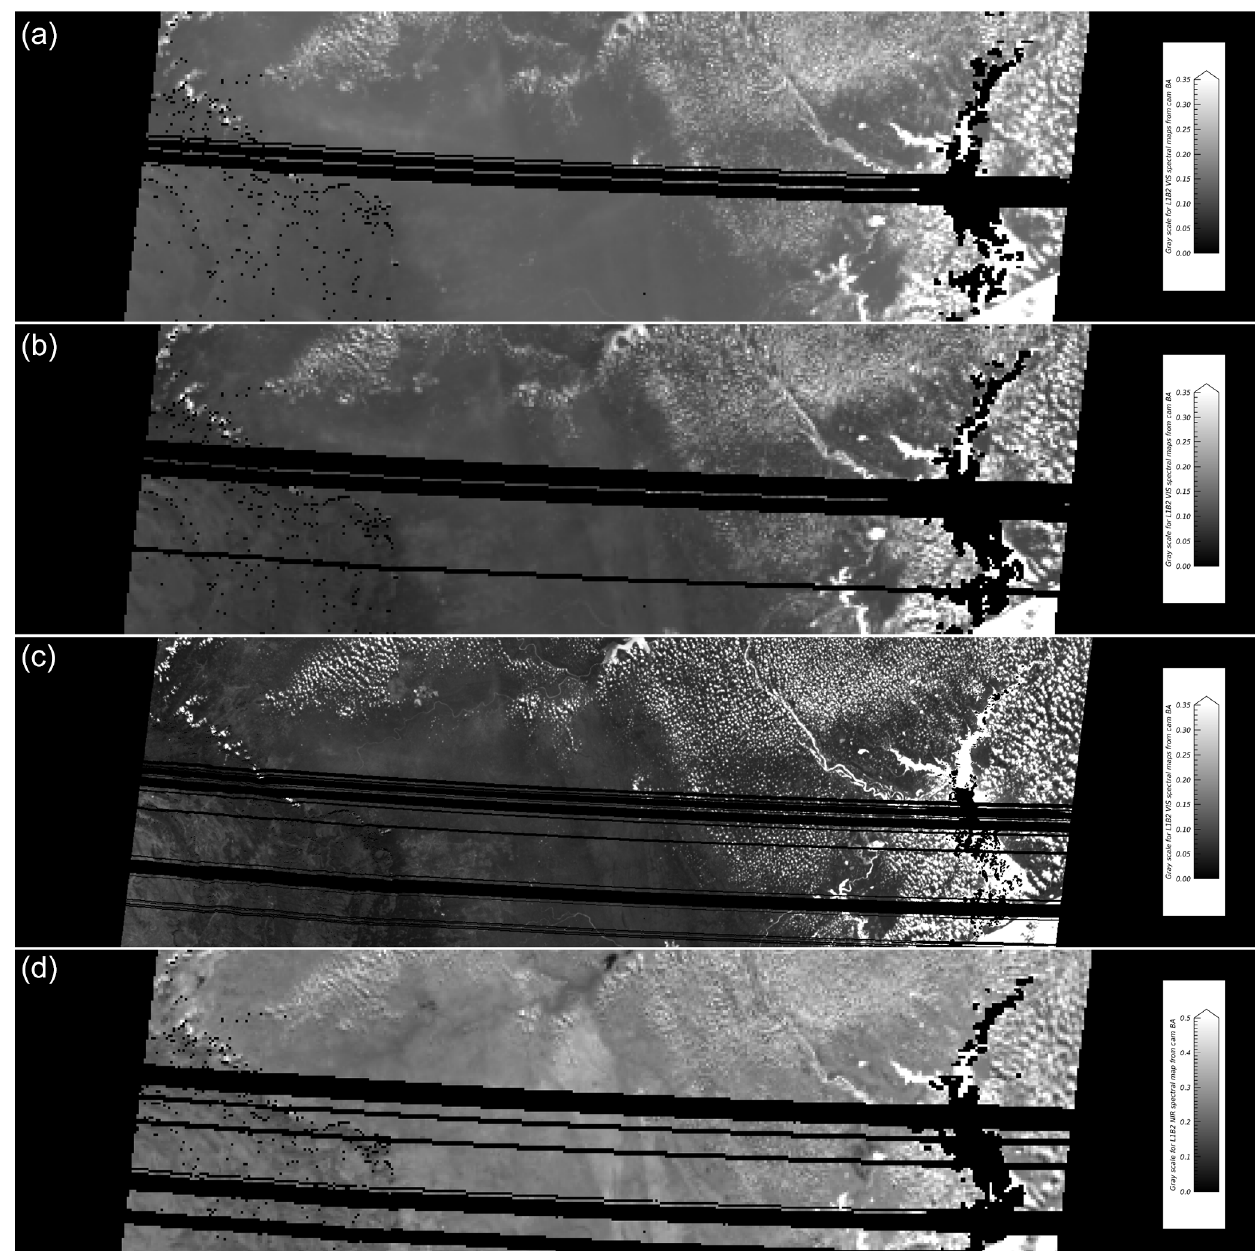
Figure 15. Maps of the original ToA bidirectional reflectance factor values for GM, P168, O002111, B110 and camera BA in (from top to bottom) the blue, green, red and NIR spectral bands. The linear dimensions are the same as in Fig. 1, and gray scale stretching is the same as before: it assigns black to a null reflectance and white to reflectances of 0.35 or more in the blue, green and red spectral bands and 0.50 in the near-infrared spectral